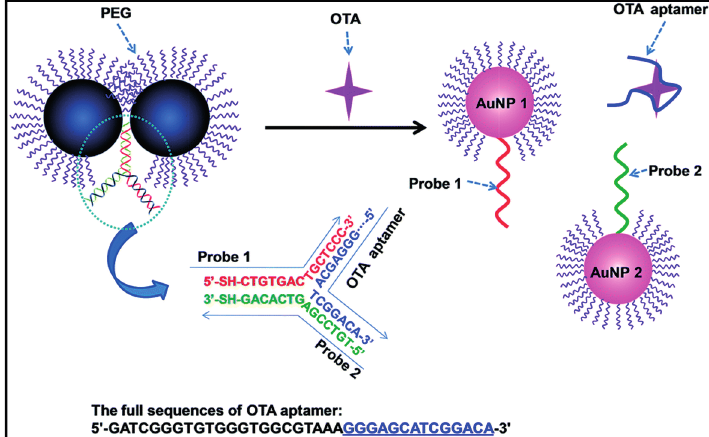
Figure 12. Sensing mechanism of the AuNP dimer-based colorimetric aptasensor for the detection of OTA (reproduced from [144] with permission of The Royal Society of Chemistry).